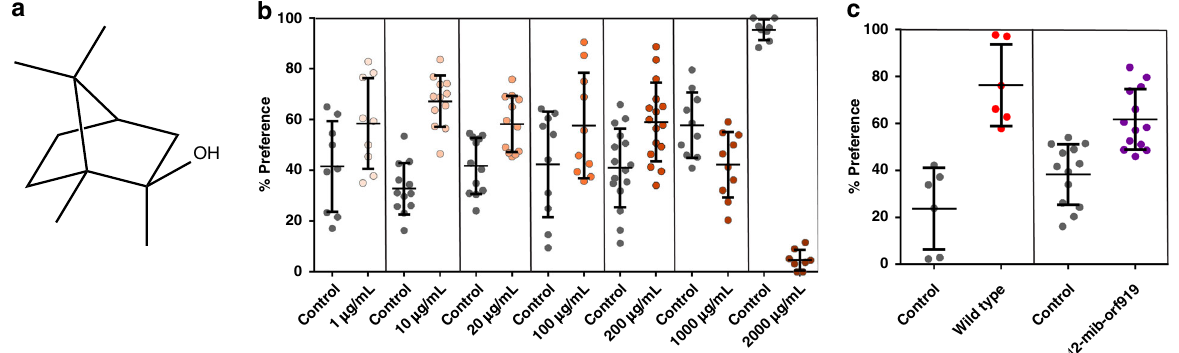
Fig. 4 Adult fl ies are attracted to Streptomyces cultures and 2-MIB. a Structure of 2-MIB. b Preference of adult fl ies to pure 2-MIB. Darker colours indicate a higher concentration of 2-MIB. The number of fl ies that preferred positions closer towards either the control or 2-MIB odorant was calculated as a percentage of total fl ies within the T-maze. c Adult fl ies placed in an enclosed space selected between a control (PBS) or contaminated food source. Contaminated food sources contained liquid culture of either the wild type or a 2-MIB deletion mutant of WAC-288. Solid horizontal lines represent the measure of centre as the mean of each data set. Error bars indicate the standard deviation of all biological and technical replicates. A two-tailed P -value of 0.014 ( n = 6) (wild-type) and 0.123 ( n = 13) (2-MIB) was calculated where a p < 0.05 is considered signi fi compounds. Indeed, the onset of toxicity and mechanism of volatile compounds can serve to attract adult fl ies such that they action between two strains WAC-288 and S. avermitilis is preferentially lay their eggs on a contaminated food source with determined by the metabolites in question: cell death in the catastrophic results for their progeny. Notably, both the killing digestive tract over a 24-h period and rapid muscle paralysis and, attraction effects are conserved in outbred strains of within minutes respectively. We also fi nd that Streptomyces D. melanogaster and other Drosophila species.